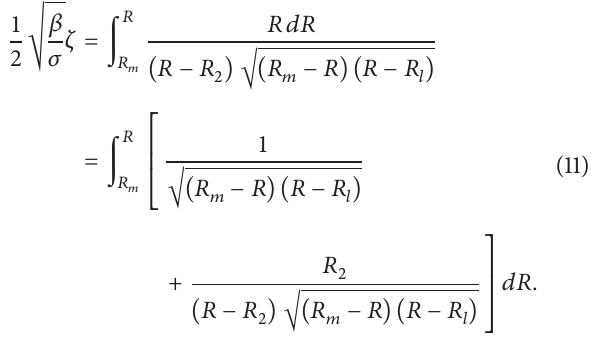
there exists a family of solitary cusp wave solutions (peakons) of (1). For example, corresponding to the homoclinic orbit in Figure 11(b), we have the peakon shown in Figure 12(a). Corresponding to the periodic orbits defined by 𝐻(𝑅, 𝑌) = ℎ , , ℎ ) in Figure 11(b), when ℎ is varied from ℎ ℎ ∈ (ℎ 2 1 the periodic wave solutions gradually lose their smoothness, from smooth periodic waves become periodic cusp waves (see Figures